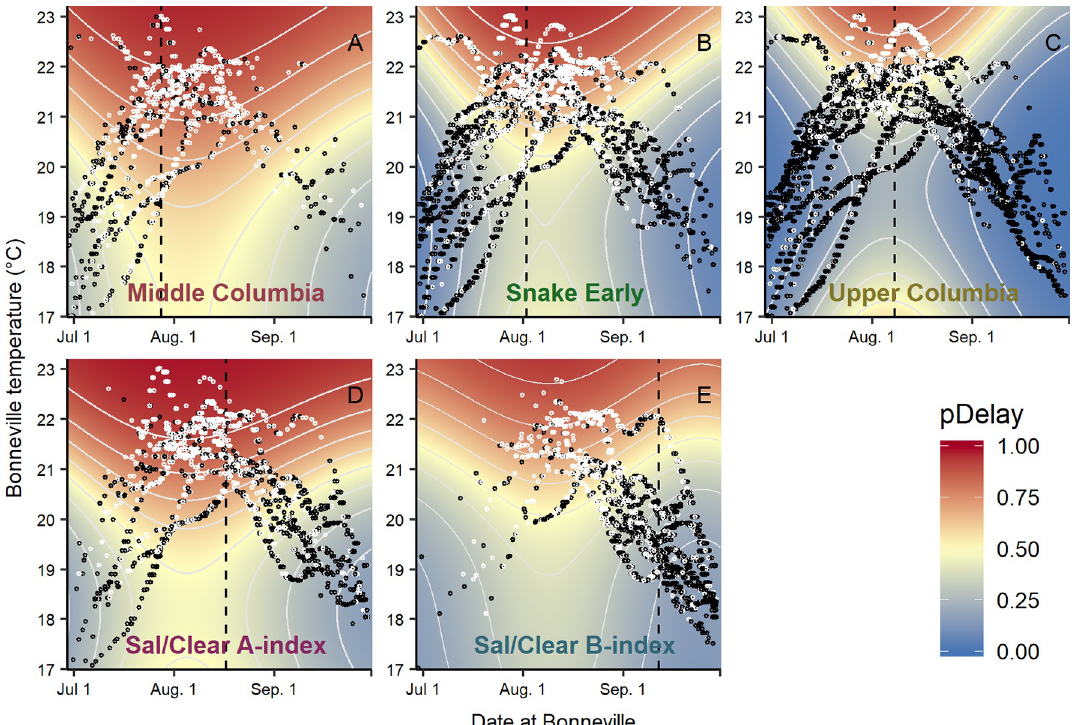
Fig 6. Probability of delay surface. The combined modeled effects for temperature and arrival date at Bonneville Dam for the probability of delay ( pDelay ) for each population group. Data used to inform models are plotted over the predicted surfaces with black circles representing designated fast migrants and white circles representing delayed migrants. Contour lines are spaced at probabilities of 0.1. Vertical dashed lines represent median arrival dates at Bonneville Dam by population groups.